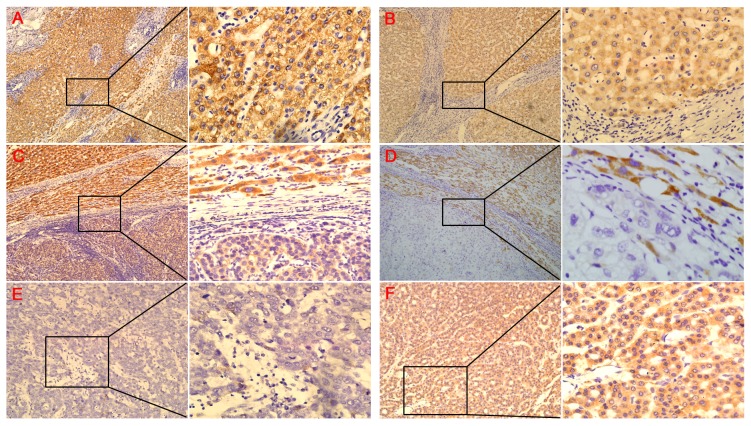
FBX8 is down-regulated in clinical paraffin-embedded HCC tissues.(A) Strong positive expression of FBX8 in adjacent normal livers (×100, ×400). (B) Positive expression of FBX8 in the cirrhotic livers (×100, ×400). (C) Week expression of FBX8 in HCC tissues while strong positive expression in adjacent livers (×200, ×400). (D) Negative expression of FBX8 in HCC tissues compared with strong positive expression in adjacent livers (×200, ×400). (E) Negative expression of FBX8 in HCC tissues with low differentiation (×200, ×400). (F) Weak expression of FBX8 in HCC tissues with high differentiation (×200, ×400).